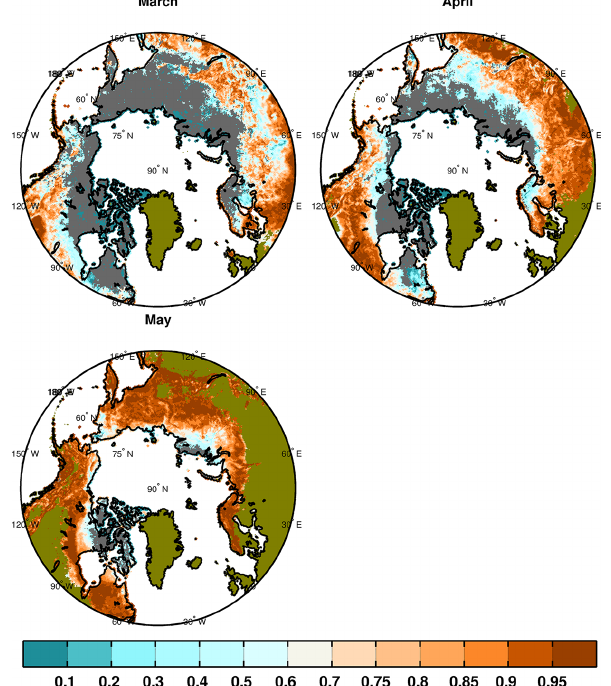
Figure 3. Albedo-SCF correlation coefficient maps. Gray color in- dicates areas where SCF is 100% throughout the study period: R could not be calculated.